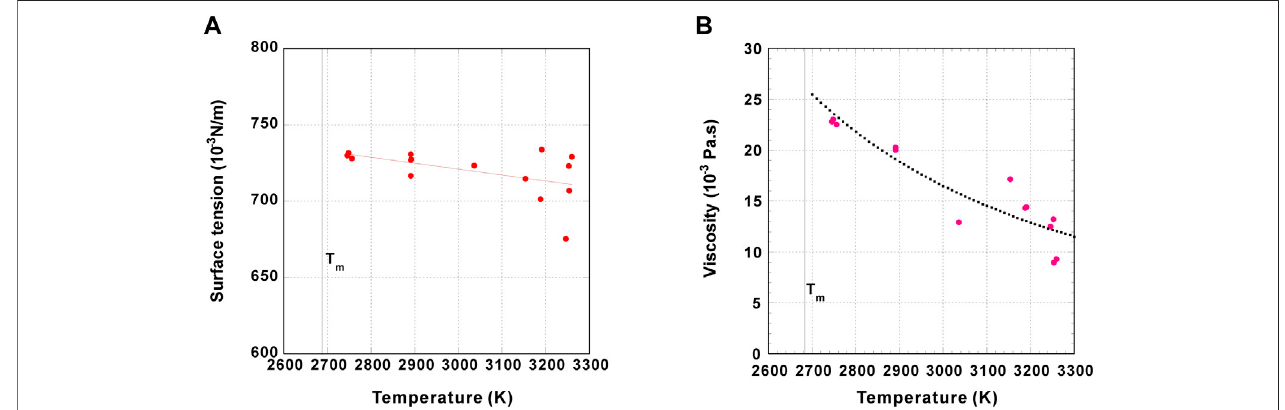
FIGURE5| Measured surface tension (A) andviscosity (B) ofmoltenTb 2 O 3 asafunctionoftemperature. The correlation coef fi cient (R)ofmeasurement is0.82for surface tension and 0.90 for viscosity, respectively.